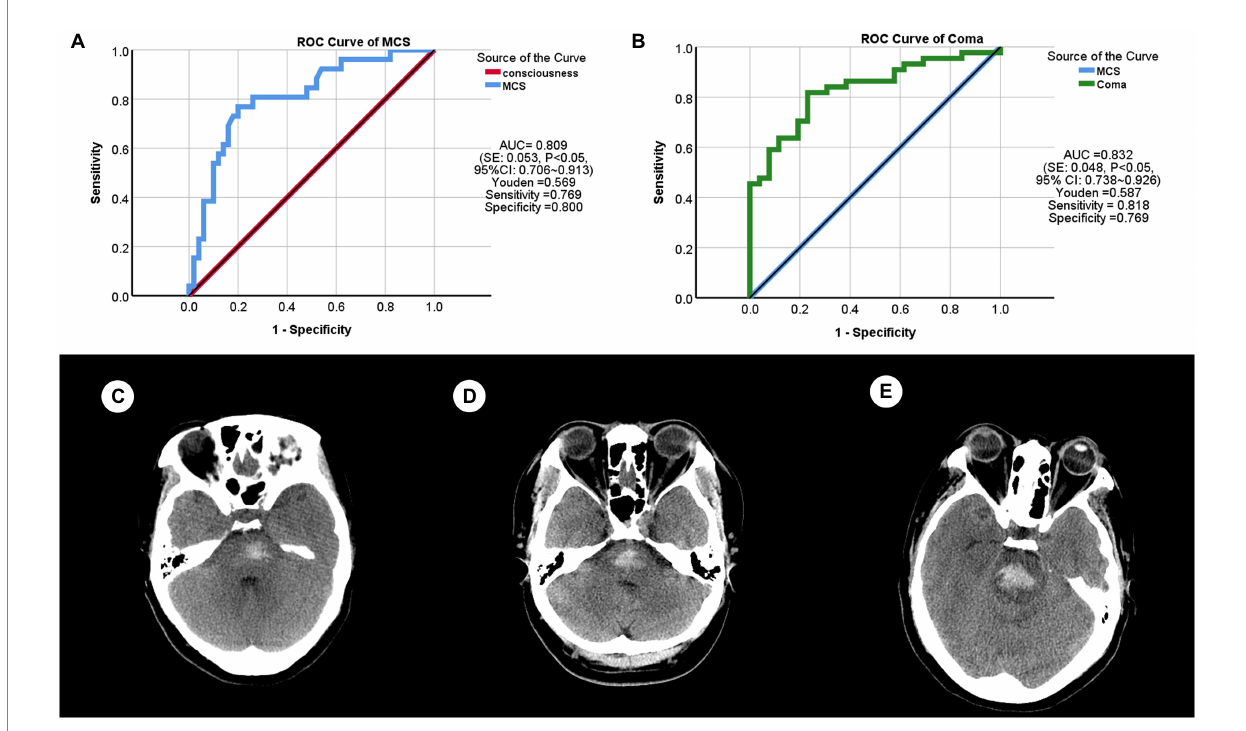
FIGURE 7 The receiver operating characteristics (ROC) curves and patient samples of primary brainstem hemorrhage (PBH). (A) ROC curve between consciousness and minimally conscious state (MCS). AUC (area under curve) = 0.809 [standard error (SE): 0.053, p < 0.05, 95% confidence interval (CI): 0.706 ~ 0.913], Youden = 0.569, sensitivity = 0.769, specificity = 0.800. (B) ROC curve between MCS and coma. AUC = 0.832 (SE: 0.048, p < 0.05, 95% CI: 0.738 ~ 0.926), Youden = 0.587, sensitivity = 0.818, specificity = 0.769. (C) This PBH patient (male, 40 years) was indicated to be consciousness and had a hemorrhage volume of 2.090 mL. (D) This PBH patient (female, 47 years) was indicated to be MCS with a hemorrhage volume of 4.820 mL. (E) This PBH patient (female, 51 years) was indicated to be coma with a hemorrhage volume of 6.950